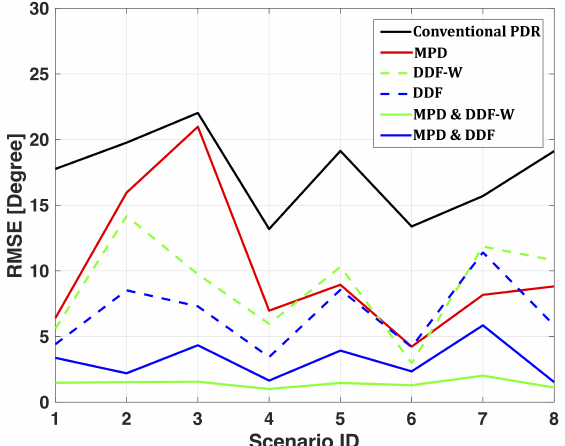
Figure 15. Heading RMSEs for the eight localization scenarios of the Large-Scale